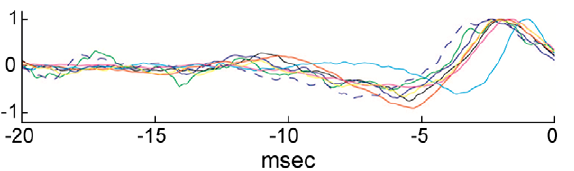
Figure 4. Optimal stimulus for eliciting a spike using the procedure described in Figure 3 for all seven preparations for which this experiment was carried out. Each signal was normalized to its maximum value that occurred within a few msec before a spike.